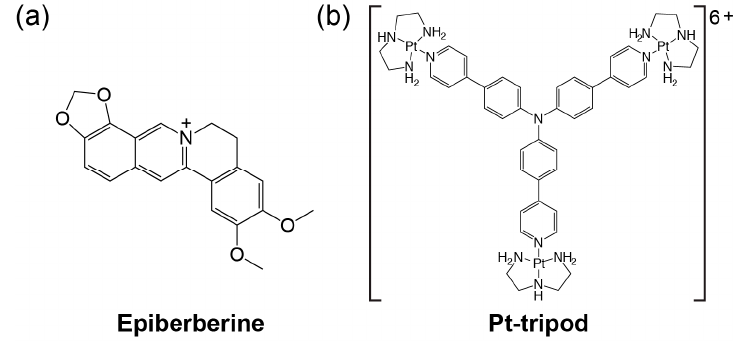
Figure 3. The chemical structures of epiberberine ( a ) and Pt-tripod ( b ).